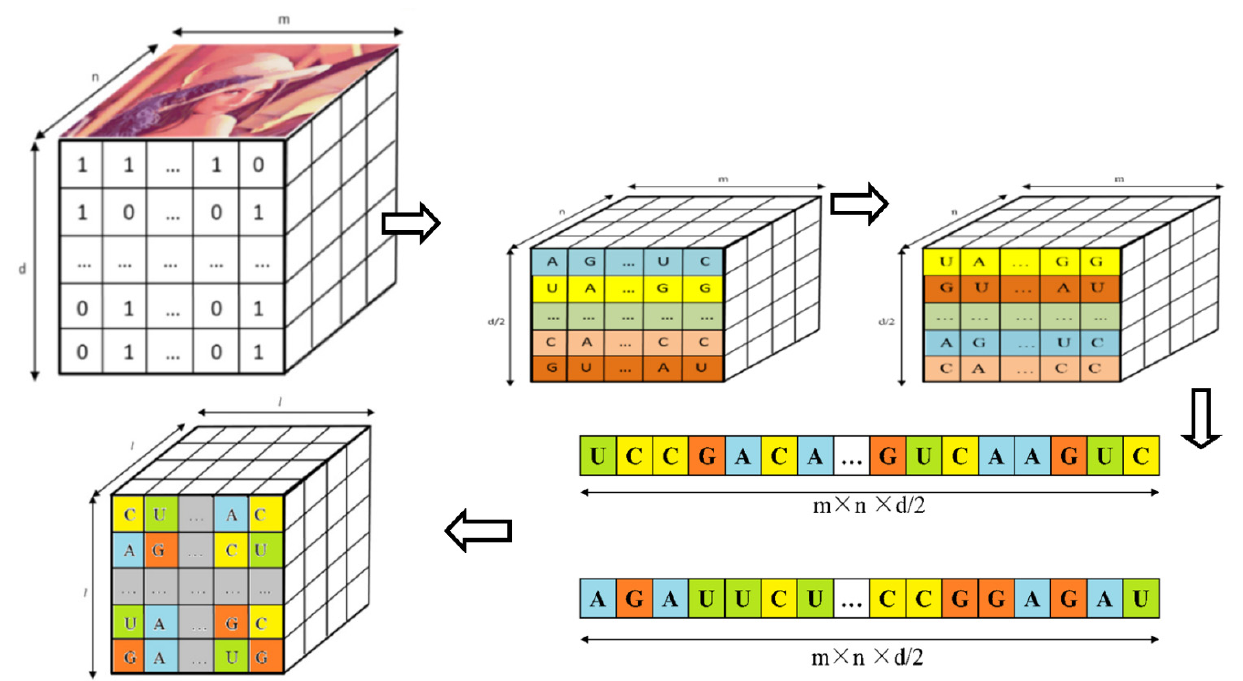
Figure 8. The schematic diagram of RNA cube